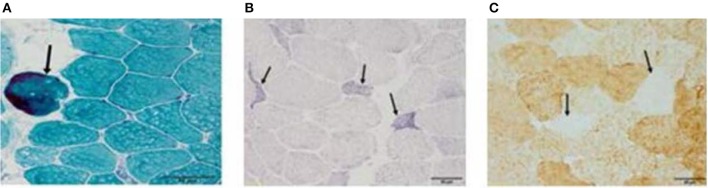
(A–C) After 4 months of hospitalization, muscle biopsy results revealed no remarkable mitochondrial abnormalities (including RRF) following histochemical analysis. However, 6 months after disease onset, modified Gomori trichrome staining of muscle biopsy specimens revealed the presence of scattered ragged red fibers (RRF, arrow in A), while succinate dehydrogenase staining revealed the presence of ragged blue fibers (arrow in B). Cytochrome C oxidase histochemical analyses revealed a diffuse reduction in the number of fibers (arrow in C). Bar represents 50 μm.